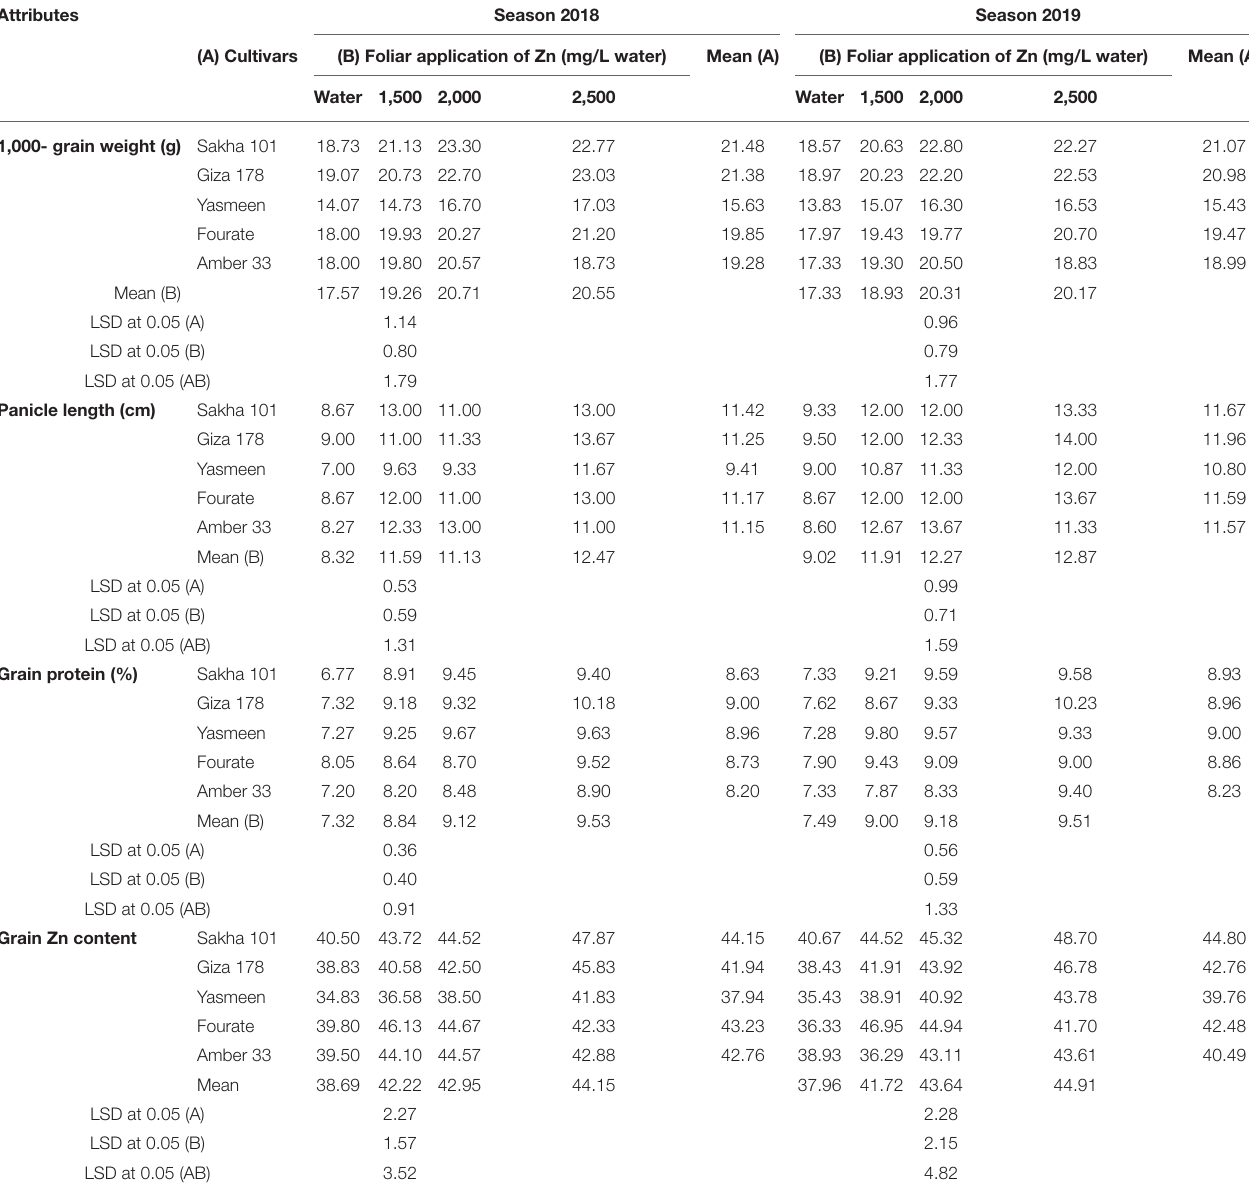
TABLE 3 | Plant attributes of some rice cultivars affected by the concentration of Zn during the 2018 and 2019 seasons.